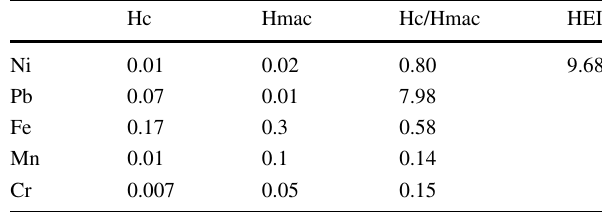
Table 10 Heavy metal evaluation index for groundwater at site